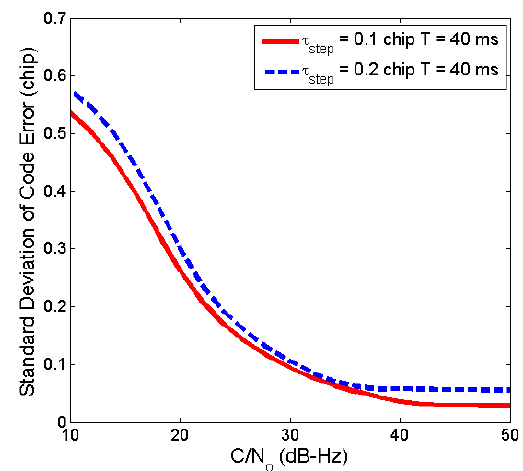
Figure 4. Detection probability of the code phase error.